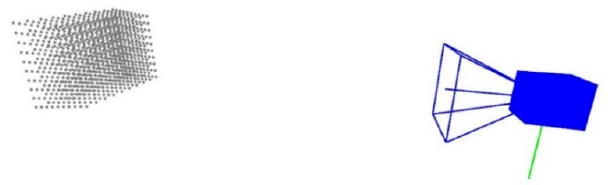
Figure 8. A virtual pyramid for camera calibration with 1000 points (10 × 10 × 10), which is displayed in an internal software to obtain intrinsic and extrinsic parameters.